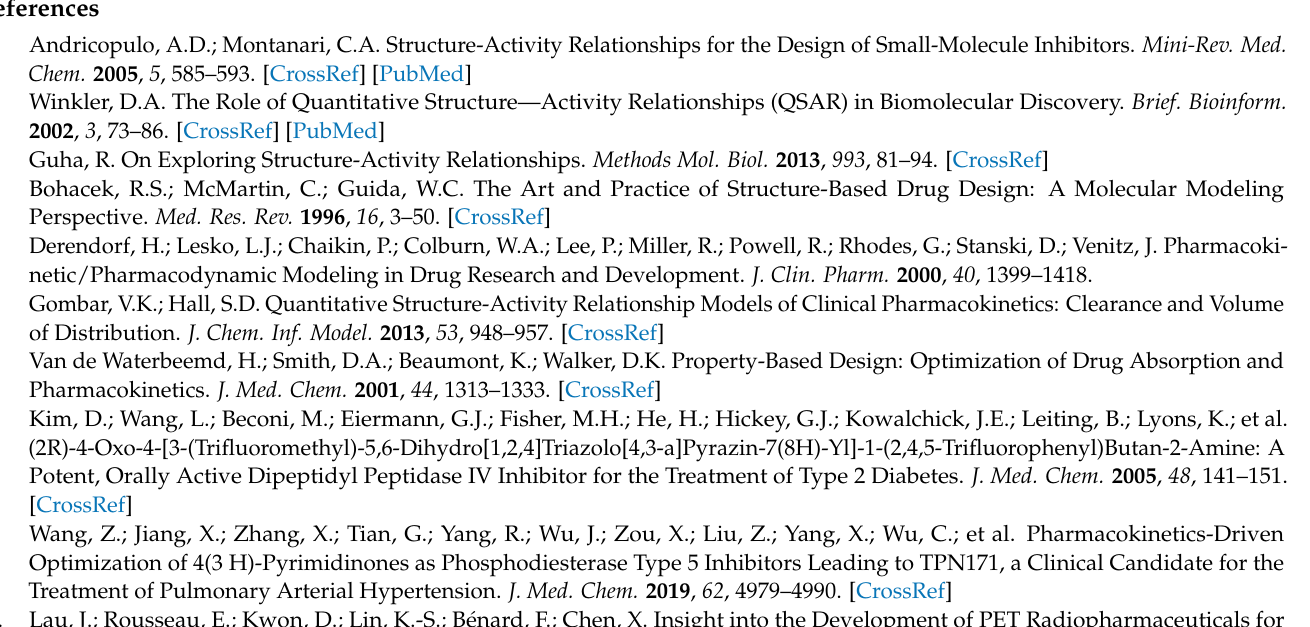
time points. Mice in the 1 h blocked group received an injection of 7.5 µ g of LY2510924 (i.p.) 15 min before tracer administration; Table S3: Biodistribution data (%ID/g) of [ 68 Ga]Ga-BL20 in Daudi tumor-bearing mice at selected time points. Mice in the 1 h blocked group received an injection of 7.5 µ g of LY2510924 (i.p.) 15 min before tracer administration; Table S4: Biodistribution data (%ID/g) of [ 68 Ga]Ga-BL17 in Daudi tumor-bearing mice at selected time points. Mice in the 1 h blocked group received an injection of 7.5 µ g of LY2510924 (i.p.) 15 min before tracer administration; Table S5: Biodistribution data (%ID/g) of [ 68 Ga]Ga-BL25 in Daudi tumor-bearing mice at selected time points; Table S6: Biodistribution data (%ID/g) of [ 68 Ga]Ga-BL31 in Daudi tumor-bearing mice at selected time points. Mice in the 1 h blocked group received an injection of 7.5 µ g of LY2510924 (i.p.) 15 min before tracer administration; Table S7: Biodistribution data (%ID/g) of [ 68 Ga]Ga-BL30 in Daudi tumor-bearing mice at selected time points; Table S8: Biodistribution data (%ID/g) of [ 68 Ga]Ga-Pentixafor in Daudi tumor-bearing mice at selected time points. Mice in the 1 h blocked group received an injection of 7.5 µ g of LY2510924 (i.p.) 15 min before tracer